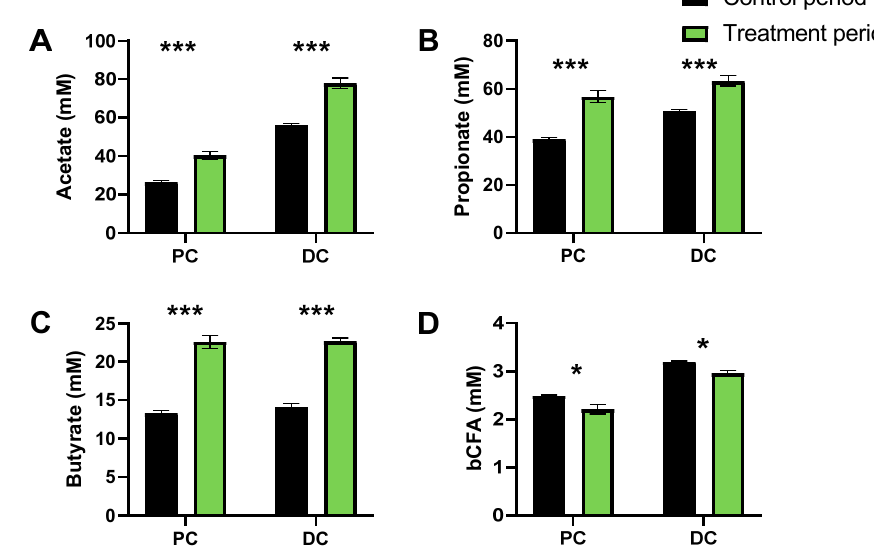
Figure 6. Effect of fermentation of FCP on microbial activity in the simulated proximal and distal colon of the triple-M-SHIME during both the final week of the control (Days 9–14) and treatment period (Days 30–35). The data is presented as the average value (± SEM) of acetate ( A ), propionate ( B ), butyrate ( C ) and bCFA ( D ), across the three samples collected per week for each of the three human adult donors tested ( n = 9). Statistically significant differences between samples collected during the final control and treatment week are indicated by */*** (0.01 < adjusted p- value < 0.05/ p < 0.001). 3.3. Repeated Adminsitration of FCP Consistently Altered Microbial Composition in the Simulated Proximal and Distal Colon with Some Interpersonal Differences across the Three Human Adults When microbial diversity in the lumen was evaluated, it remained unaffected. In to 22.9 ± 3.1 in the mucosal environment of the distal colon (adjusted p -value = 0.017) (Figure 7).